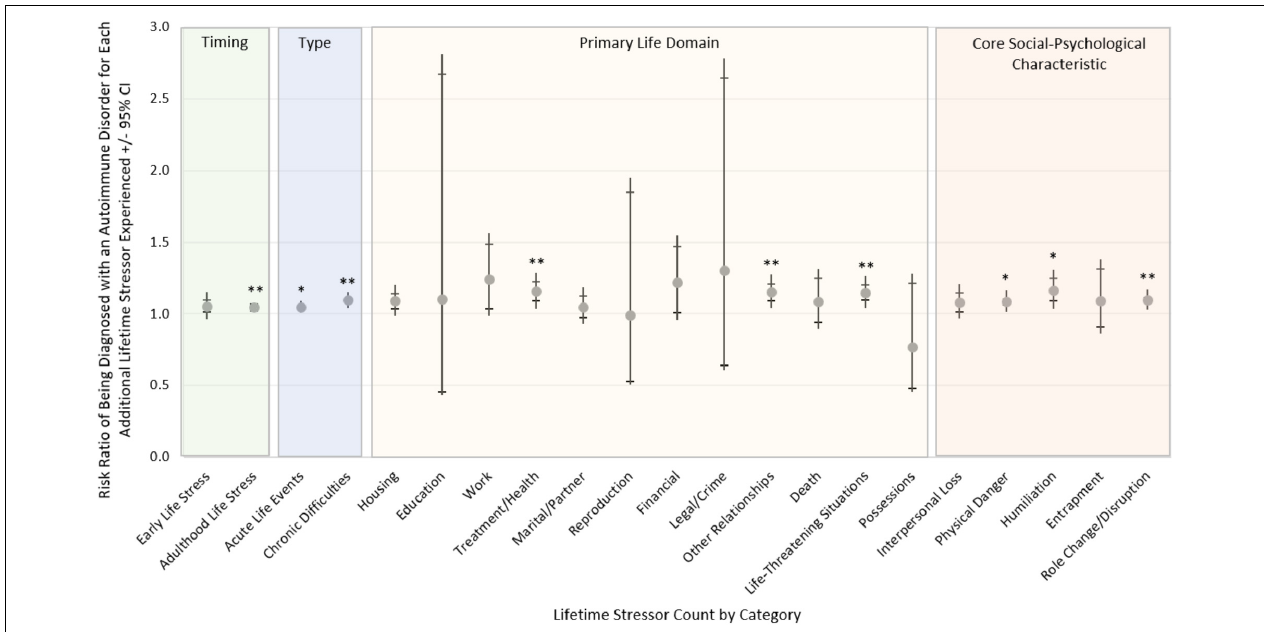
FIGURE 4 | Likelihood of being diagnosed with an autoimmune disorder by stressor timing, type, primary domain, and core social-psychological characteristic. Risk of being diagnosed with an autoimmune disorder differed substantially across the different types of life stressors experienced, controlling for participants’ age, gender, race, socioeconomic status, and negative affect. More specifically, participants’ risk was greater for those experiencing adulthood vs. early life stressors and for those experiencing chronic vs. acute stressors. Risk was also greater for individuals experiencing stressors involving treatment/health, other relationships, life-threatening situations, physical danger, humiliation, and role change/disruption. ∗ p < 0.05, ∗∗ p < 0.01 ( n =